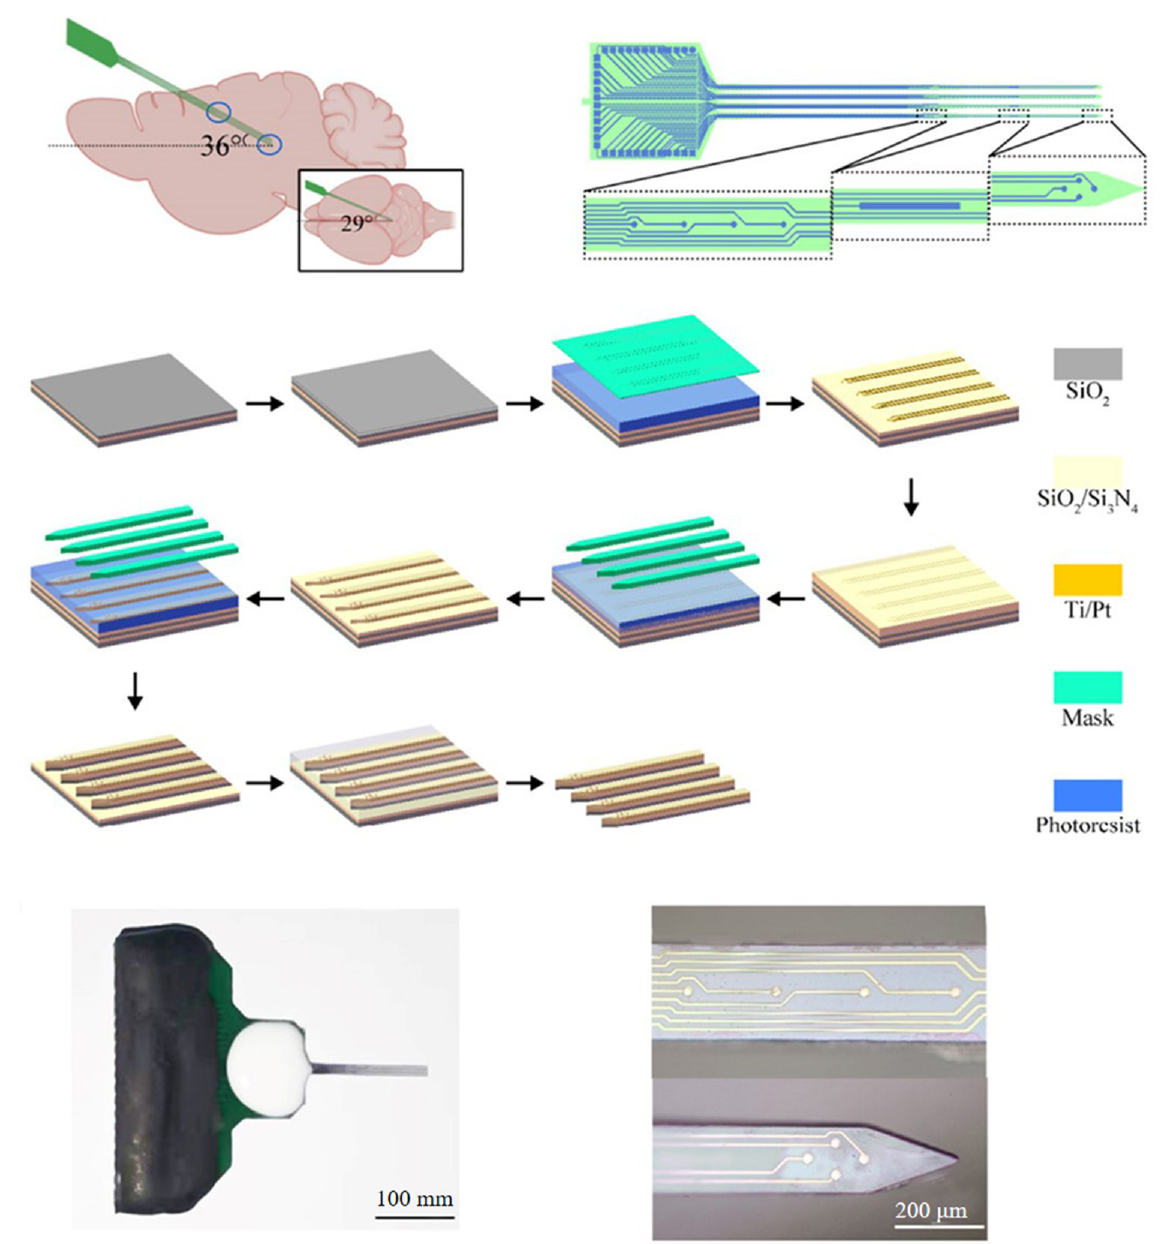
Figure 7. The design and fabrication of MEA.